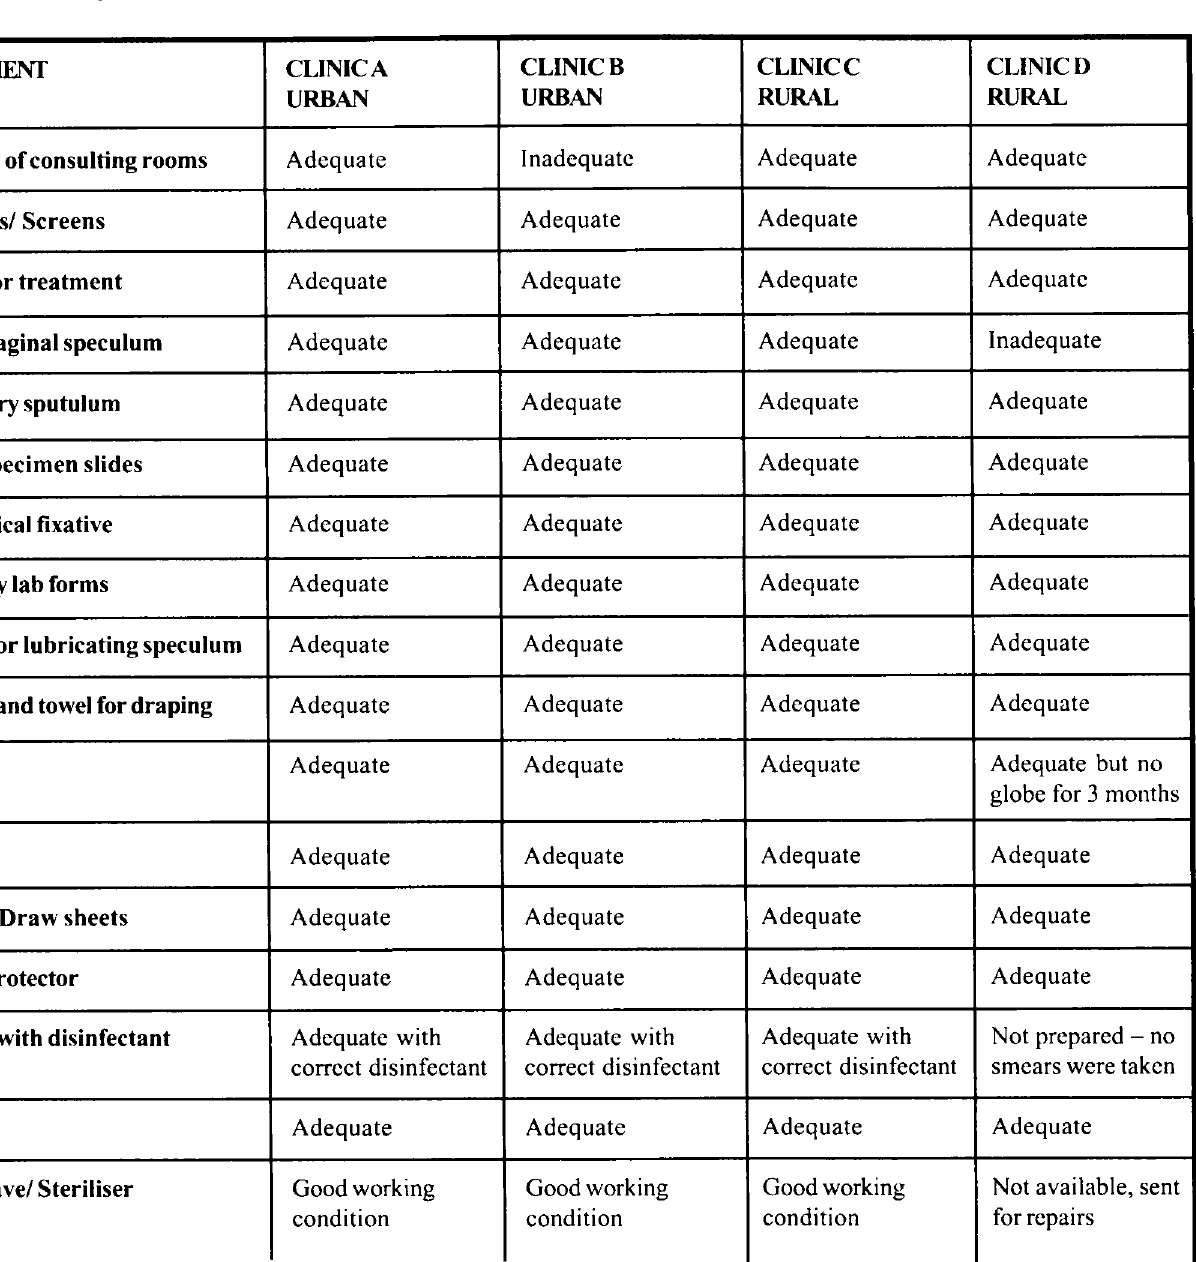
Table 1: Summary of clinic audit findings